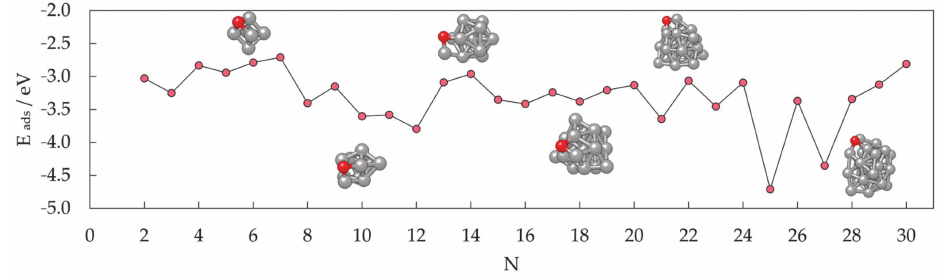
Figure 6. DFT-calculated adsorption energies for single-atom oxygen adsorption on small (2 ≤ N ≤ 30) Co